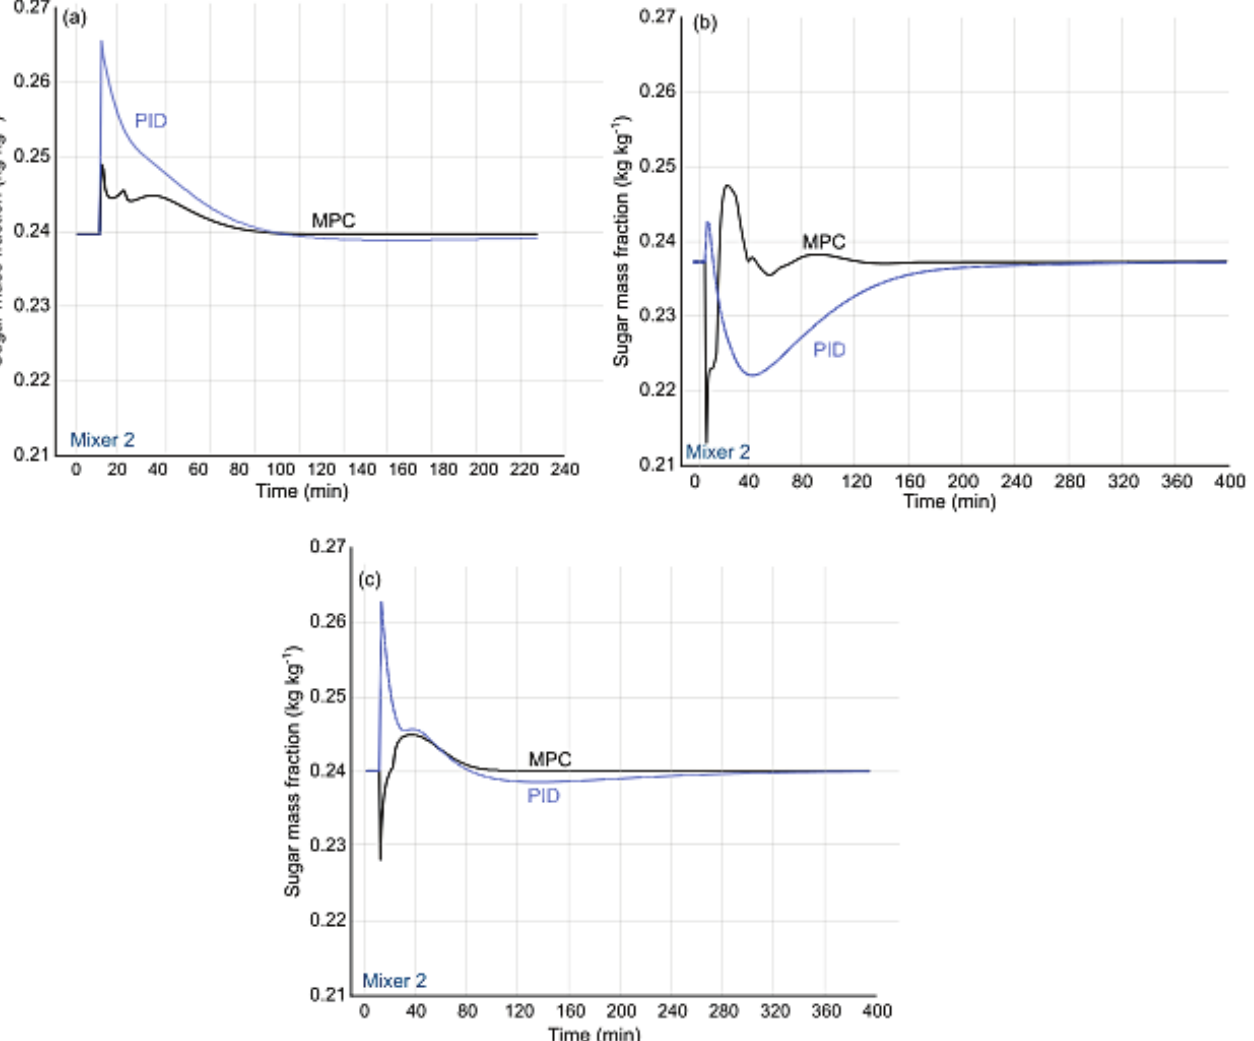
Fig. 6 – Responses of MPC and PID controlled evaporators on the second mixer to simultaneous step disturbances in juice sugar concentration and temperature (a), juice volumetric flow rate and temperature (b), and juice sugar concentration and volumetric flow rate